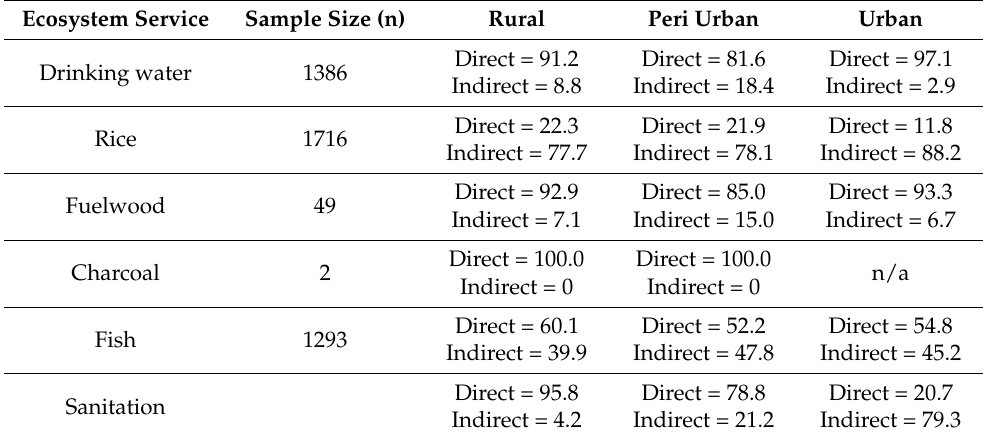
Direct = 91.2 Direct = 81.6 Direct = 97.1 Indirect = 8.8 Indirect = 18.4 Indirect = 2.9 Direct = 22.3 Direct = 21.9 Direct = 11.8 Indirect = 77.7 Indirect = 78.1 Indirect = 88.2 Direct = 92.9 Direct = 85.0 Direct = 93.3 Indirect = 7.1 Indirect = 15.0 Indirect = 6.7 Direct = 100.0 Direct = 100.0 n/a Indirect = 0 Indirect = 0 Direct = 60.1 Direct = 52.2 Direct = 54.8 Indirect = 39.9 Indirect = 47.8 Indirect = 45.2 Direct = 95.8 Direct = 78.8 Direct = 20.7 Indirect = 4.2 Indirect = 21.2 Indirect =